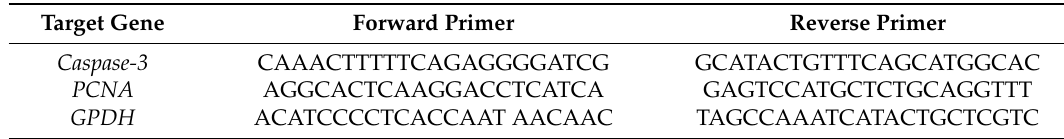
Table 1. Primer sequences for the investigated genes.